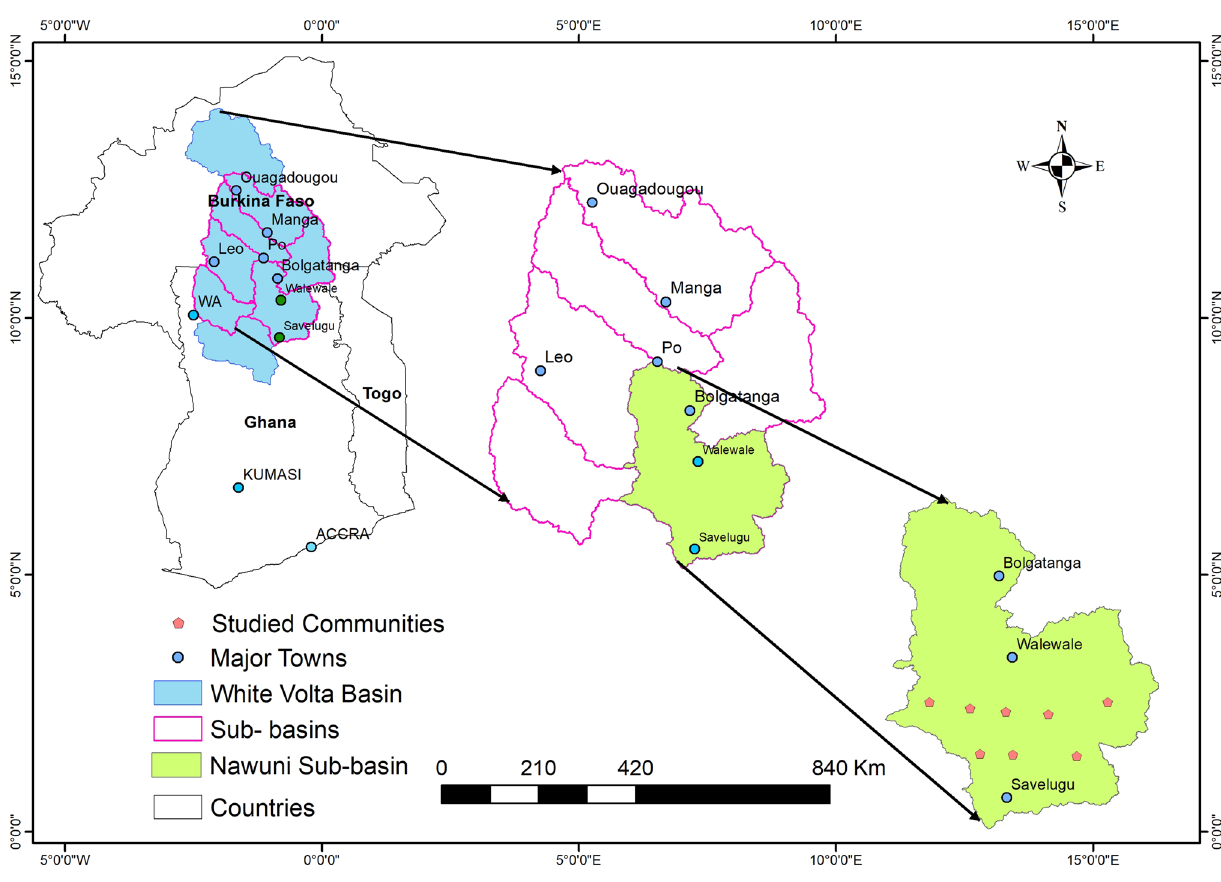
Fig. 1 Map of Nawuni Catchment area (Adopted from Baatuuwie